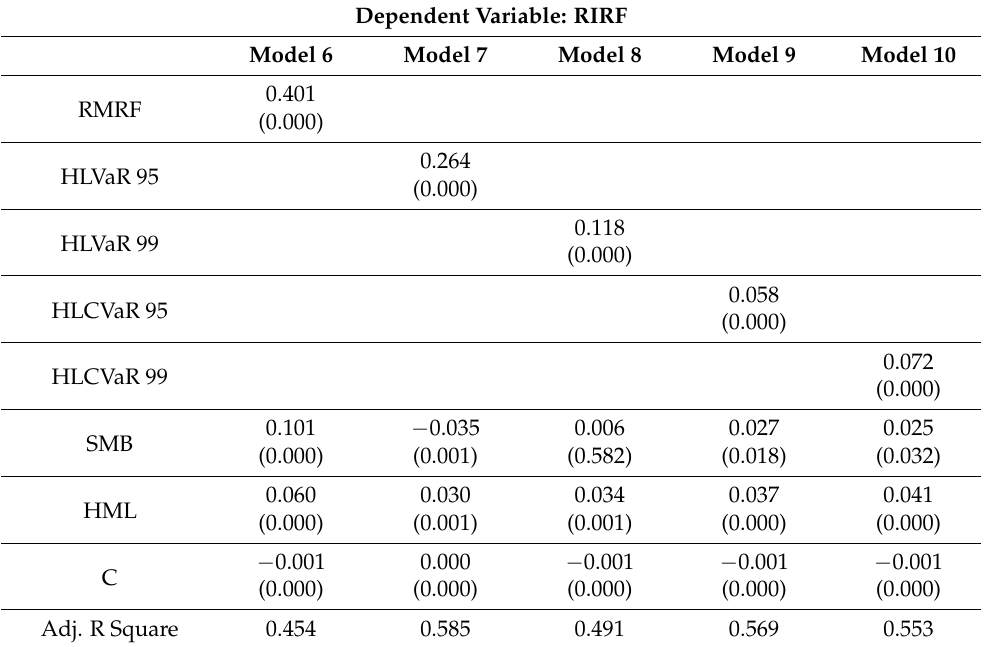
Table 7. Three-factor model using market Beta, VaR, and ES. The table represents five models with the dependent variable of excess returns of manufacturing companies listed in Pakistan Stock Exchange. Independent variables include all the systematic risk factors that the study proposed. Market excess return RmRf calculated from the subtraction of KSE 100 Index returns from the risk-free rate of returns. HLVaR is the subtraction of average returns of High VaR portfolio returns from Low VaR portfolio returns. VaR is observed at both 95% and 99% level of significance. HLCVaR represents subtraction of high ES return stocks from low ES returns stocks. SMB provides a size factor; HML is a value factor. All models give results on the three-factor model with substituting systematic risk factor. Italic probability value is provided below every coefficient value representing the significance of the coefficient effect dependent